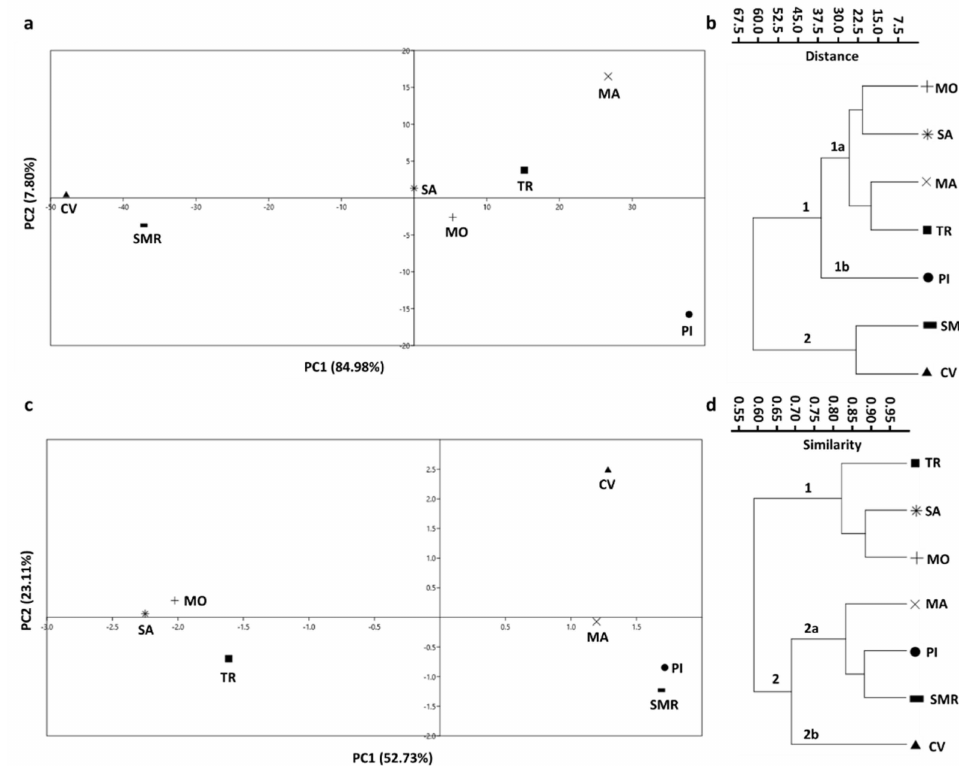
Figure 1. Principal component analysis (PCA) and UPGMA clustering of common bean morpho- logical features and genetic data. Scatter plot of the PCA computed among seven populations of Phaseolus vulgaris L., using fifteen morphological features ( a ) and dendrogram resulting from a clus- ter analysis using the unweighted pair group method with arithmetic mean (UPGMA) with the Euclidean distance index ( b ). Scatter plot of the PCA computed on the seven bean populations, using eight inter-simple sequence repeat (ISSR) primers ( c ) and dendrogram resulting from UPGMA clustering (Jaccard similarity index) ( d ). CV: Ciliegino; SMR: San Michele Rosso; MO: Monachella; MA: Mascherino; PI: Pinto; TR: Tuvagliedda Rossa; SA: Suocera e